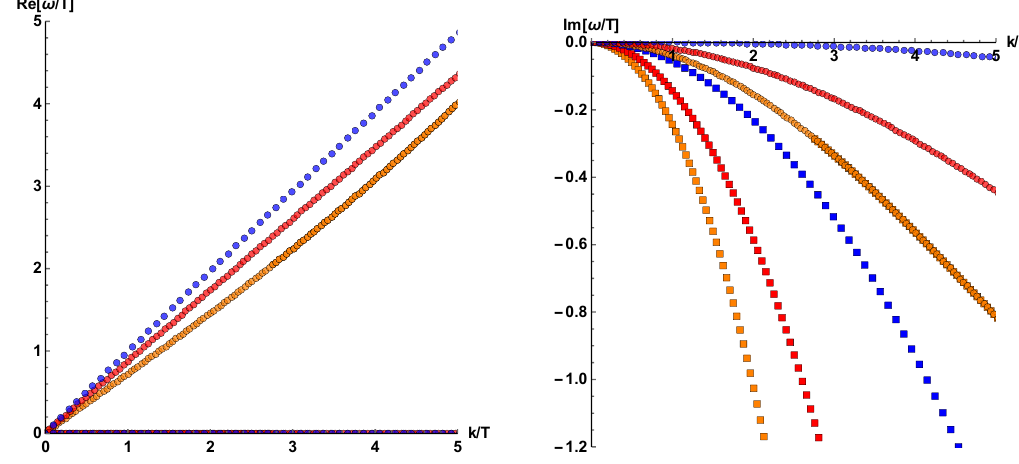
Figure 2 . A snapshot of the typical dispersion relations for the sound mode (disks) and the di(cid:11)usive mode (squares). The speci(cid:12)c example pertains to the potential V ( X ) = X 3 for m=T = 0 ; 3 ; 11 (from orange to blue).